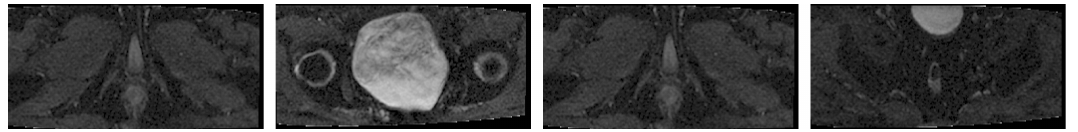
Figure 3. Some examples containing no prostate tissue. These slices were mostly from the top or the bottom slices in a whole 3D